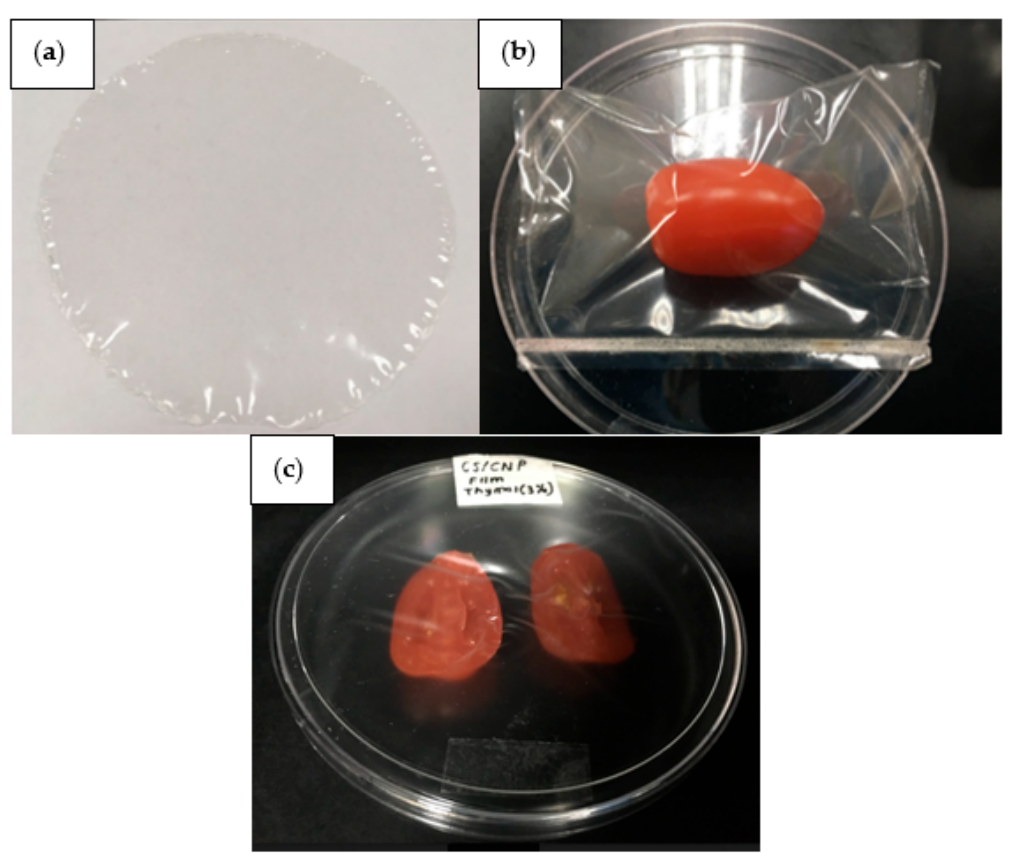
Figure 2. ( a ) Starch/CNP/Thy bio-nanocomposite film; ( b ) cherry tomato that was packed using the produced film; ( c ) sliced cherry tomato that was placed in the petri dish, in direct contact with the film for the shelf-life observation study.